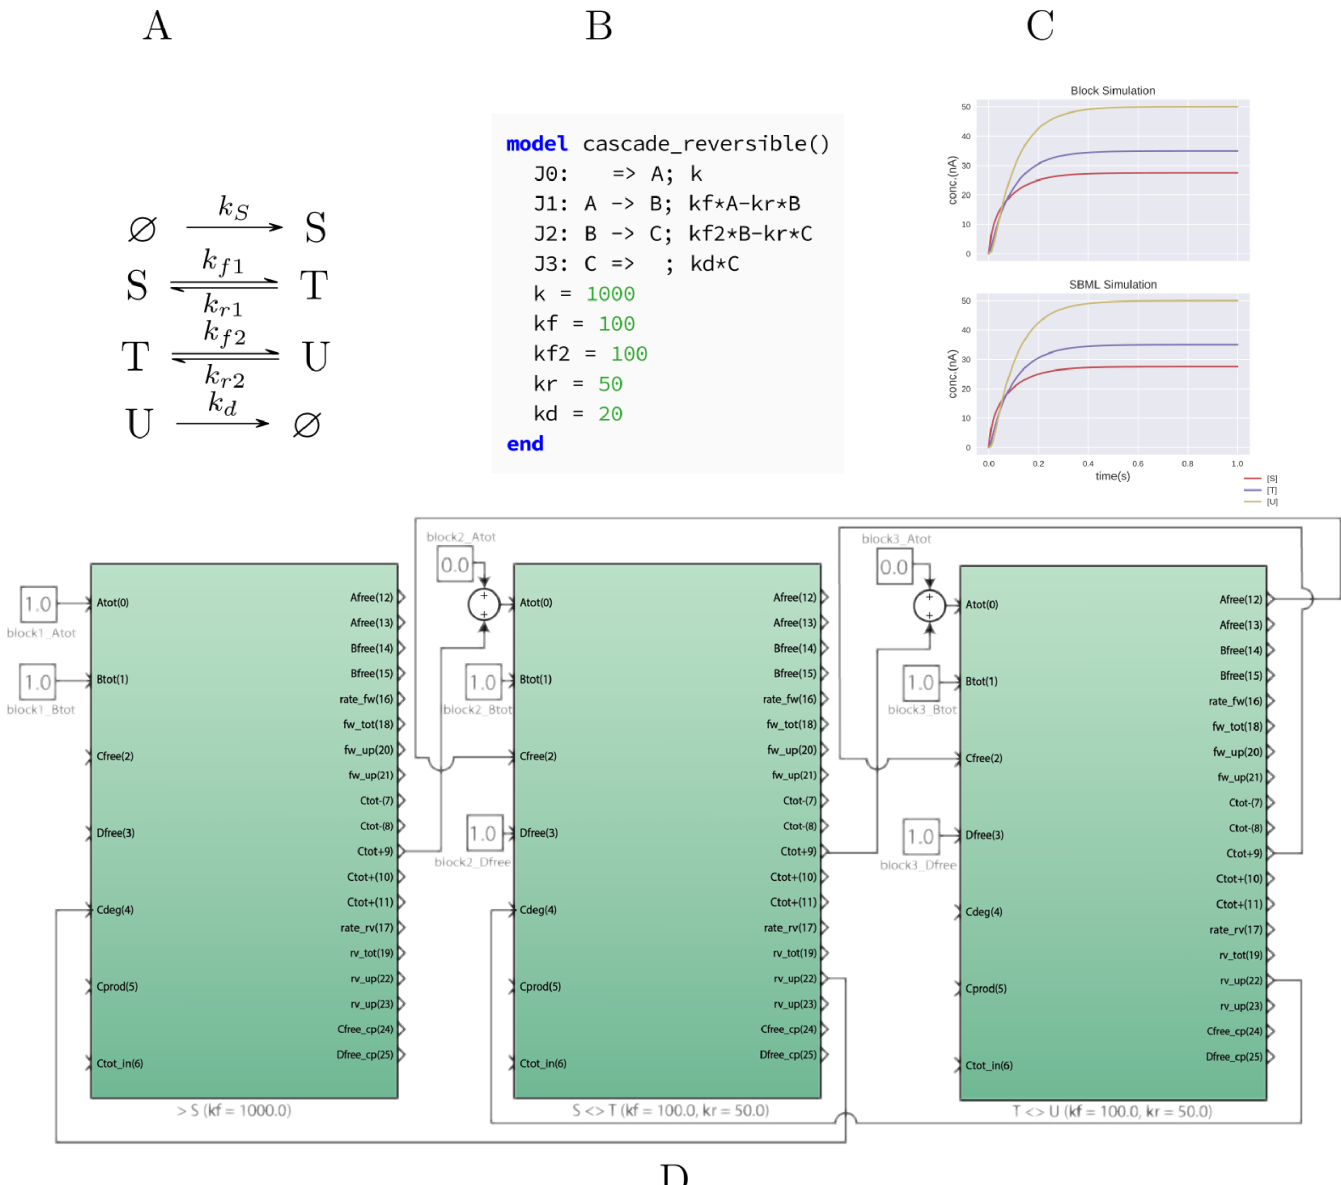
Fig 6. A three–step feed–forward network. This network is comprised of a linear chain of unimolecular mass–action processes (A). To convert this network to a wiring, we designate blocks 1–3 as the main produces of species S , T , and U respectively. Block 1 produces S , hence its main output port C is connected to the A tot tot input of block 2 and so on. This signal is summed with the initial value of T (if non–zero). Since the cytomorphic chip uses currents for computation, summing signals is achieved simply by connecting multiple signals to the same input port. The last block in the chain, which produces U , also serves as a degradation reaction U (cid:0) ! k d ⌀ . The block has its ratC parameter set to the degradation rate k . Additionally, the amount of U degraded must also be subtracted from the total values of S and T . The d rv_up port computes the total loss in C for each block and is propagated to the block immediately upstream by connecting to the Cdeg port. The Antimony/SBML model for this network (B) is converted to a block simulation that gives identical output to the SBML simulation (C). Since this is a mass–action network, numerical differences can be made arbitrarily small by adjusting integrator tolerances. All connections created by the compiler are shown in the wiring diagram. More info is available at https://github.com/cytocomp1/cytocomp/tree/master/case-studies.